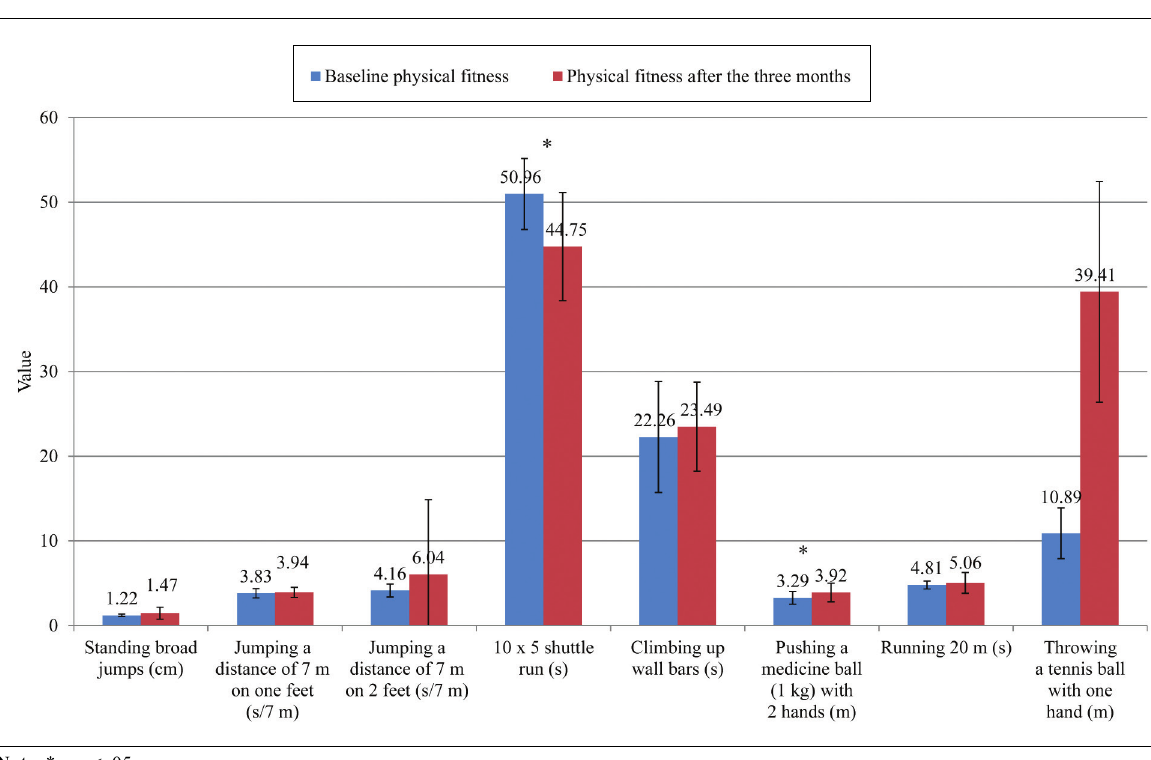
Note. * – p < .05. Figure 1. Changes of physical fitness in three months in the control group of girls